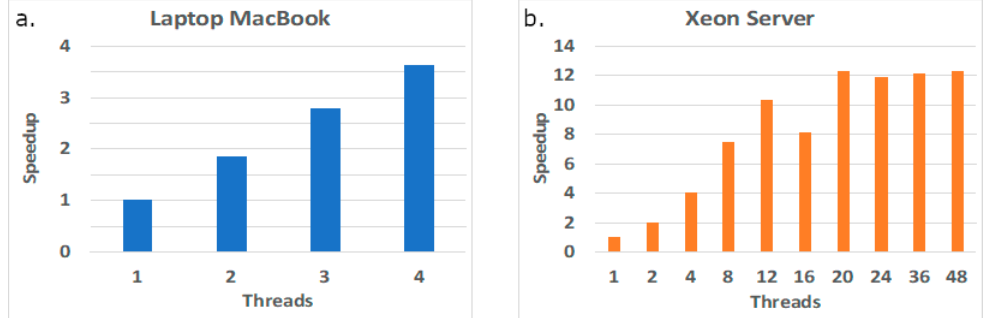
Figure 5. Performance scalability in two computing platforms: laptop MacBook (a) and Xeon server (b).